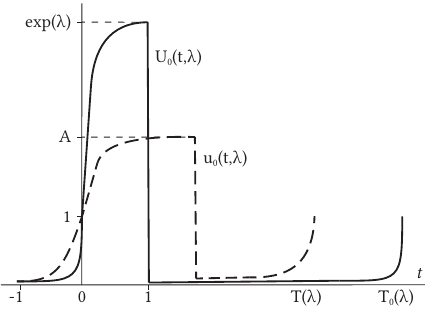
Figure 2. Form of the functions u 0 ( t , λ ) , U 0 ( t , λ )